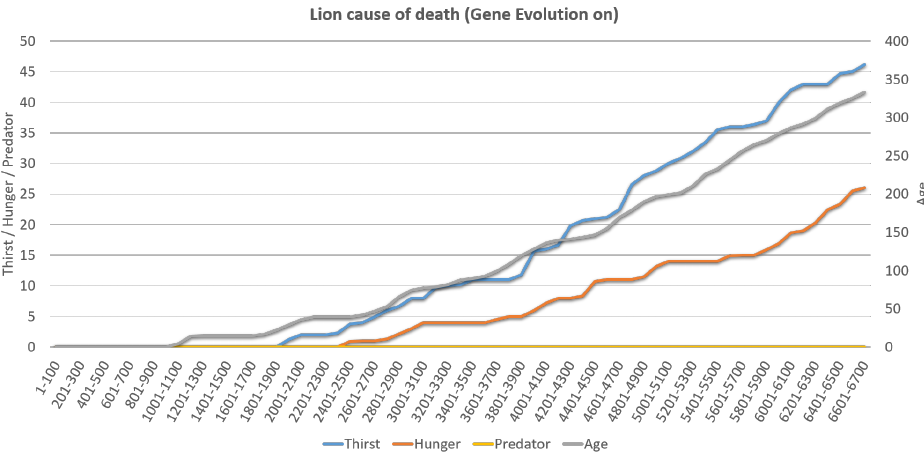
Figure 21. The diagram shows the cause of deaths for the Lion population with the new system. Figures 21 and 22 show the difference between the new gene evolution system turned on and off. The vertical axis shows the population and the horizontal axis shows the simulation time in seconds, displayed in 100-s interval categories. On the left, we can see Thirst/Hunger/Predator as a lower determining cause factor, and on the right, Age, which is a 10 times higher determining cause in the evolution system than other causes.